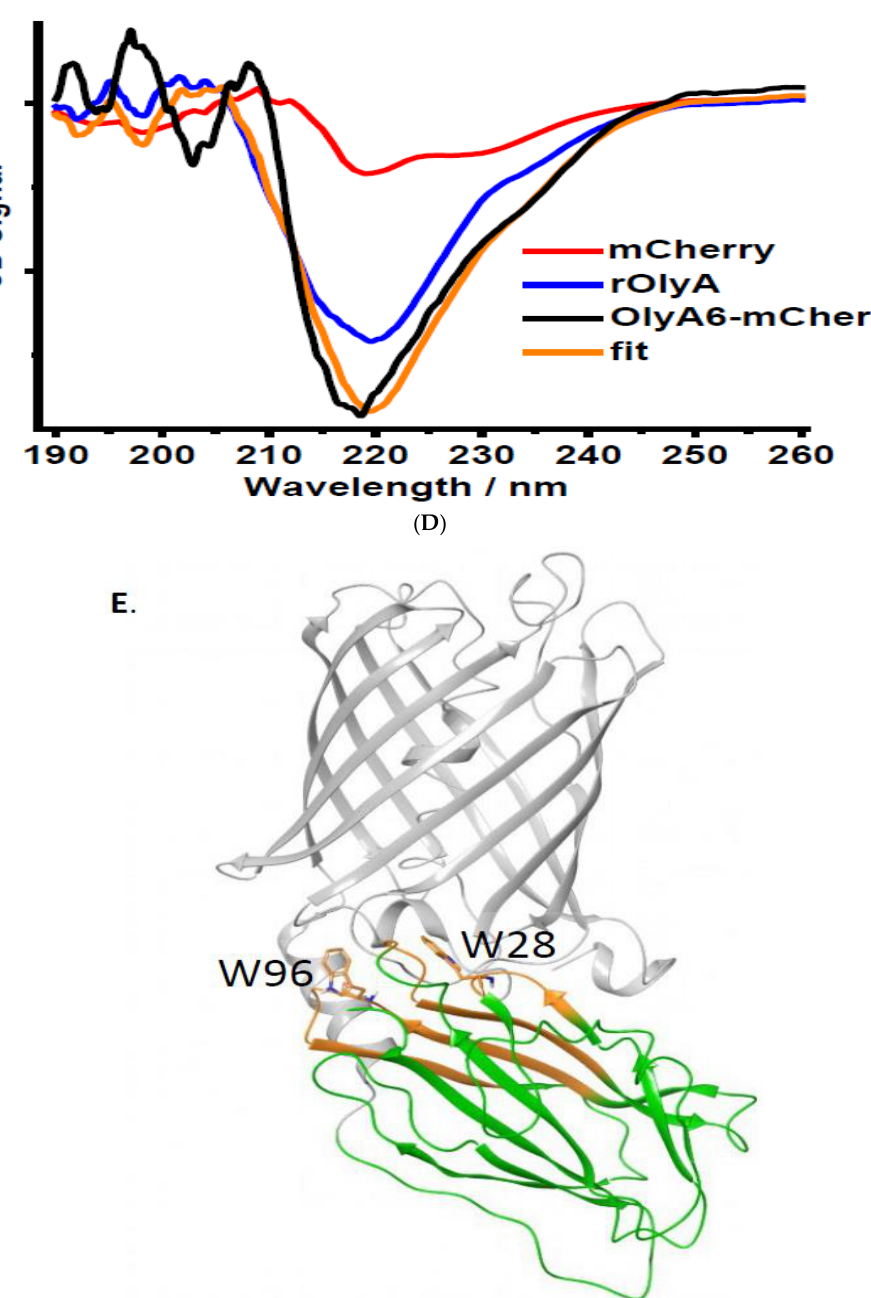
Figure 4. Functionality of OlyA6-mCherry. Dose response — live HIB-1B cells with rOlyA, OlyA6- mCherry incubation and imaging at two time points: 8 h ( A ) and 72 h ( B ) post-treatment. HIB-1B cells treated with OlyA6- mCherry 0 μg mL −1 (control), 10 μg mL −1 , 30 μg mL −1 and 50 μg mL −1 for 8 or 72 h. Bright field (40×), scale bar = 50 µm. ( C ) CD spectra of OlyA6-mCherry, mCherry and rOlyA in the secondary-structure spectral region. The mCherry and rOlyA spectra are similar and the OlyA6-mCherry spectrum is the combination of both spectra. ( D ) OlyA6-mCherry spectra were sep- arated into OlyA6 (red) and mCherry (black). The combined form of the spectra of OlyA6 protein and mCherry (blue) is plotted against the OlyA6-mCherry spectra (orange). Distinct 220 nm peaks of OlyA6 and mCherry indicate mainly β -sheet structures. ( E ) Structural model of OlyA6-mCherry. mCherry is represented as a gray cartoon and OlyA6 as a green cartoon. The region of OlyA6 interact- ing with mCherry is shown as an orange cartoon, and W28 and W96 are represented as orange sticks.